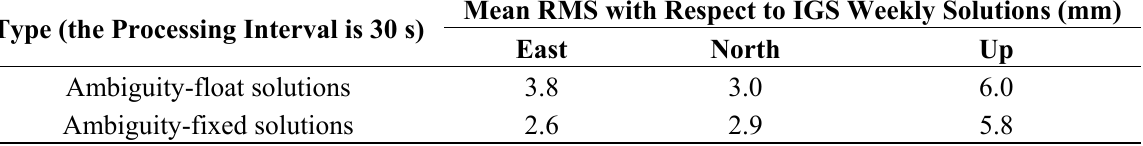
Table 1. Mean RMS of station coordinates with respect to IGS weekly